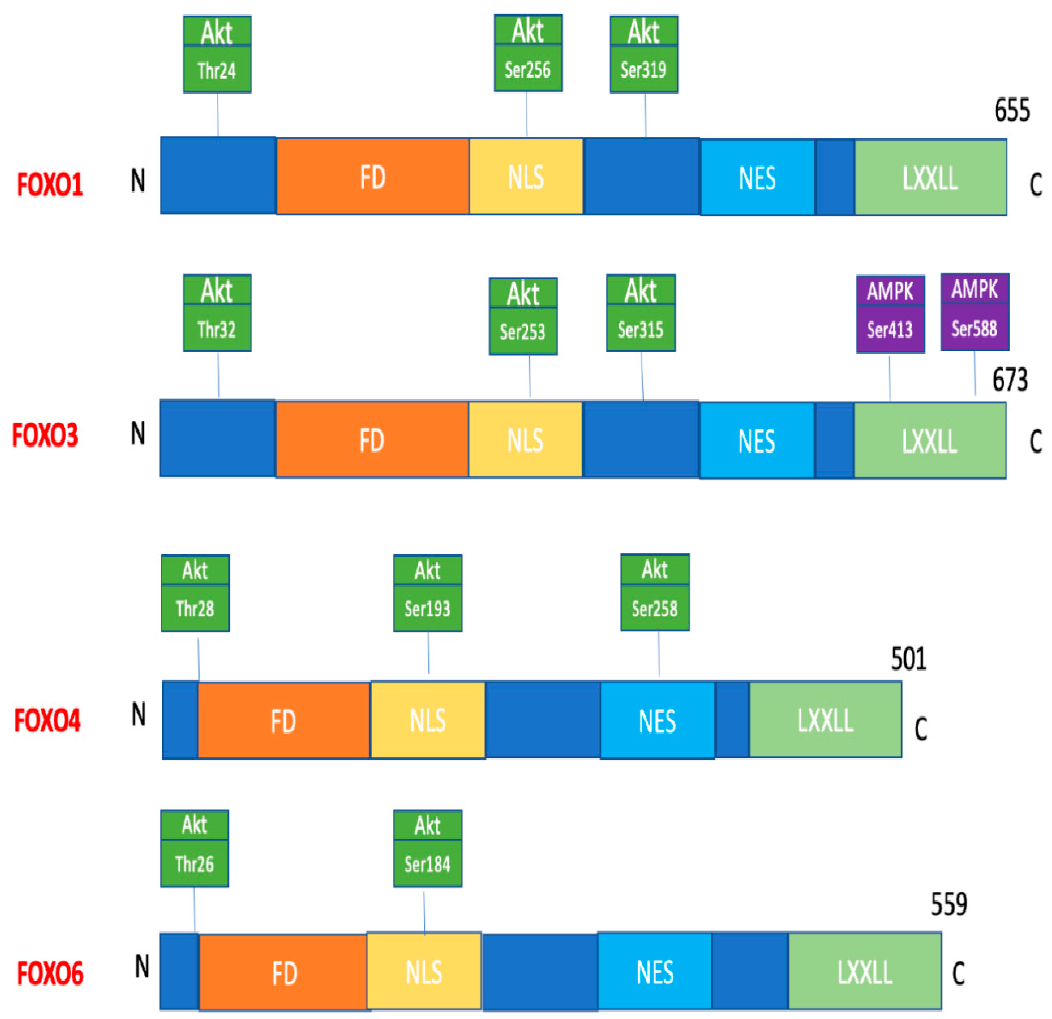
Figure 1. Description of mammalian FOXO proteins expressed in skeletal muscle. The following are indicated: locations of the forkhead domain (FD), nuclear localisation sequence (NLS), nuclear export sequence (NES) and helical motif (LXXLL), Akt phosphorylation sites (green squares) and AMPK phosphorylation sites (purple squares) [4].